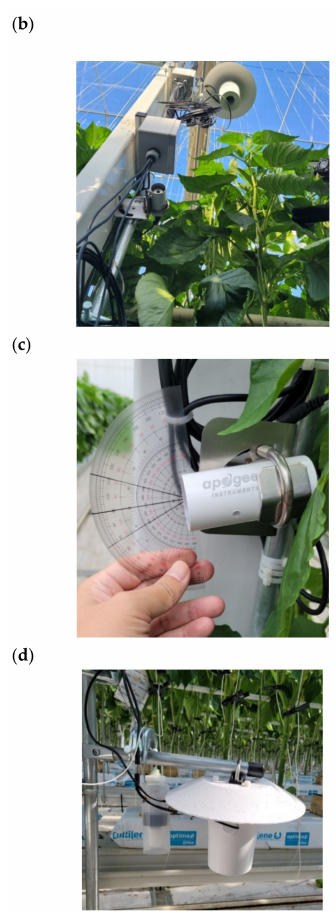
Figure 8. Pictures of sensor installation in the greenhouse. Full mount was taken at LAI 1.0 to show the overall installation ( a ). Temperature, relative humidity, and CO 2 sensors of upper air ( b ), infrared sensor adjusted with view angle ( c ), and temperature, relative humidity, and CO 2 sensors of upper air ( d ) were installed.